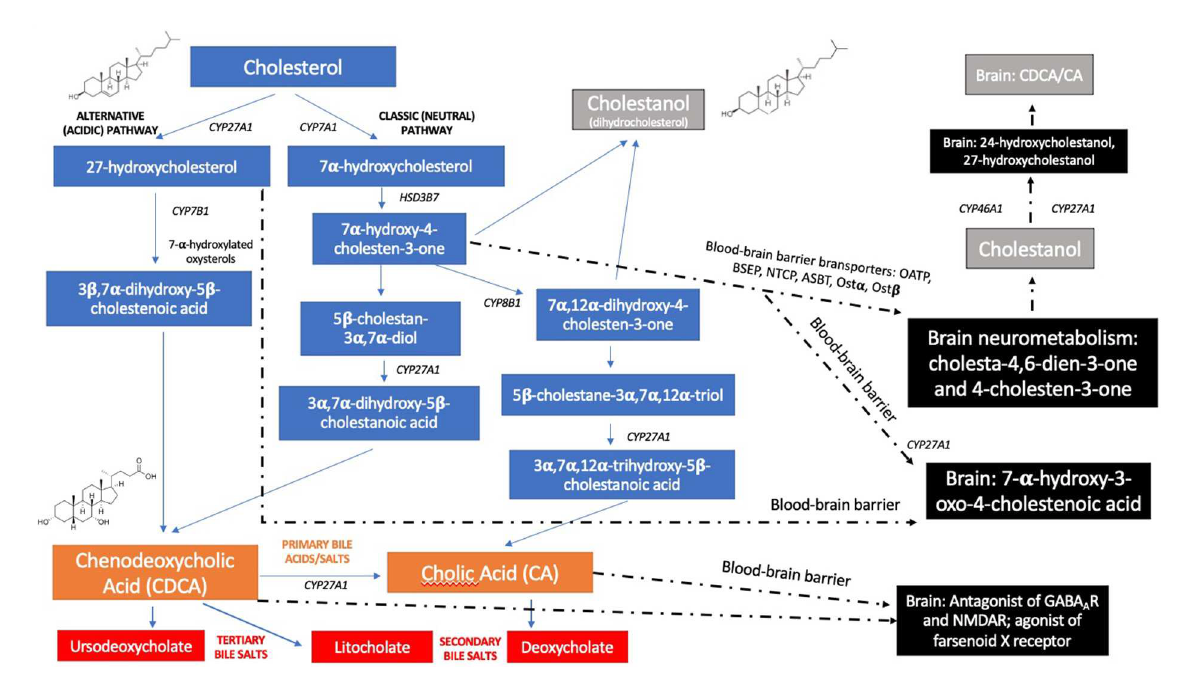
FIGURE2 Natural history, disease progression and symptom and sign timeline in each phenotype of CTX (classical, spinal, and “non-neurological” forms), according to the age of symptom-onset (1, 6, 7, 12, 17, 18).